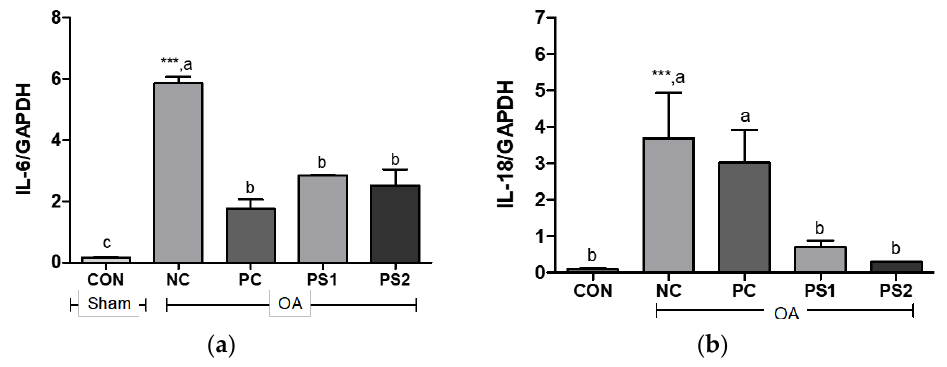
Figure 6. Effects of PS on cytokines expression in the cartilage with synovial membrane of OA rats. ( a ) IL-6 and ( b ) IL-18. Data are expressed as the mean ± SE (n = 4/group). CON: normal sham control; NC: negative control; PC: positive control; PS1: PS at 100 mg/kg BW; PS2: PS at 300 mg/kg BW. NC group was significantly different from the CON group at *** p < 0.001 by Student’s t test. a – c Mean values with different letters are significantly different ( p < 0.05) among groups by Duncan’s multiple range test.